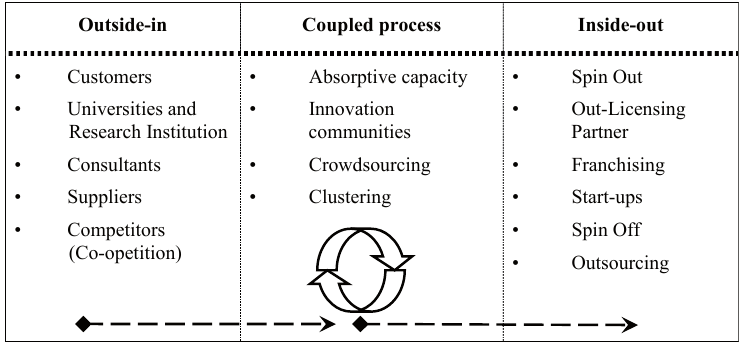
Fig. 3 - Pillars of open innovation model (Source: Lameras, Hendrix, Lengyel et al.,